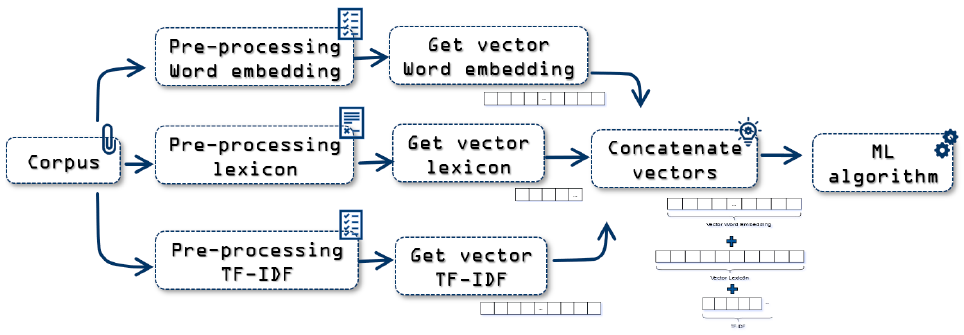
Figure 8. Process approach WE_Lexicon_TF-IDF.